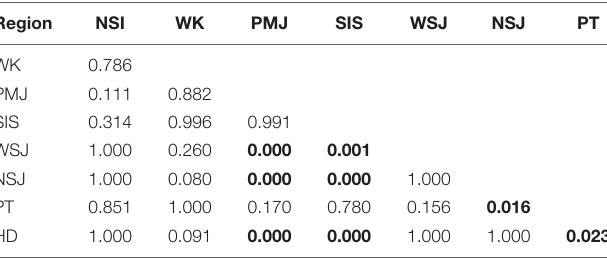
TABLE 2 | Results of the Tukey HSD test comparing the average eDNA concentrations between the regions. Region